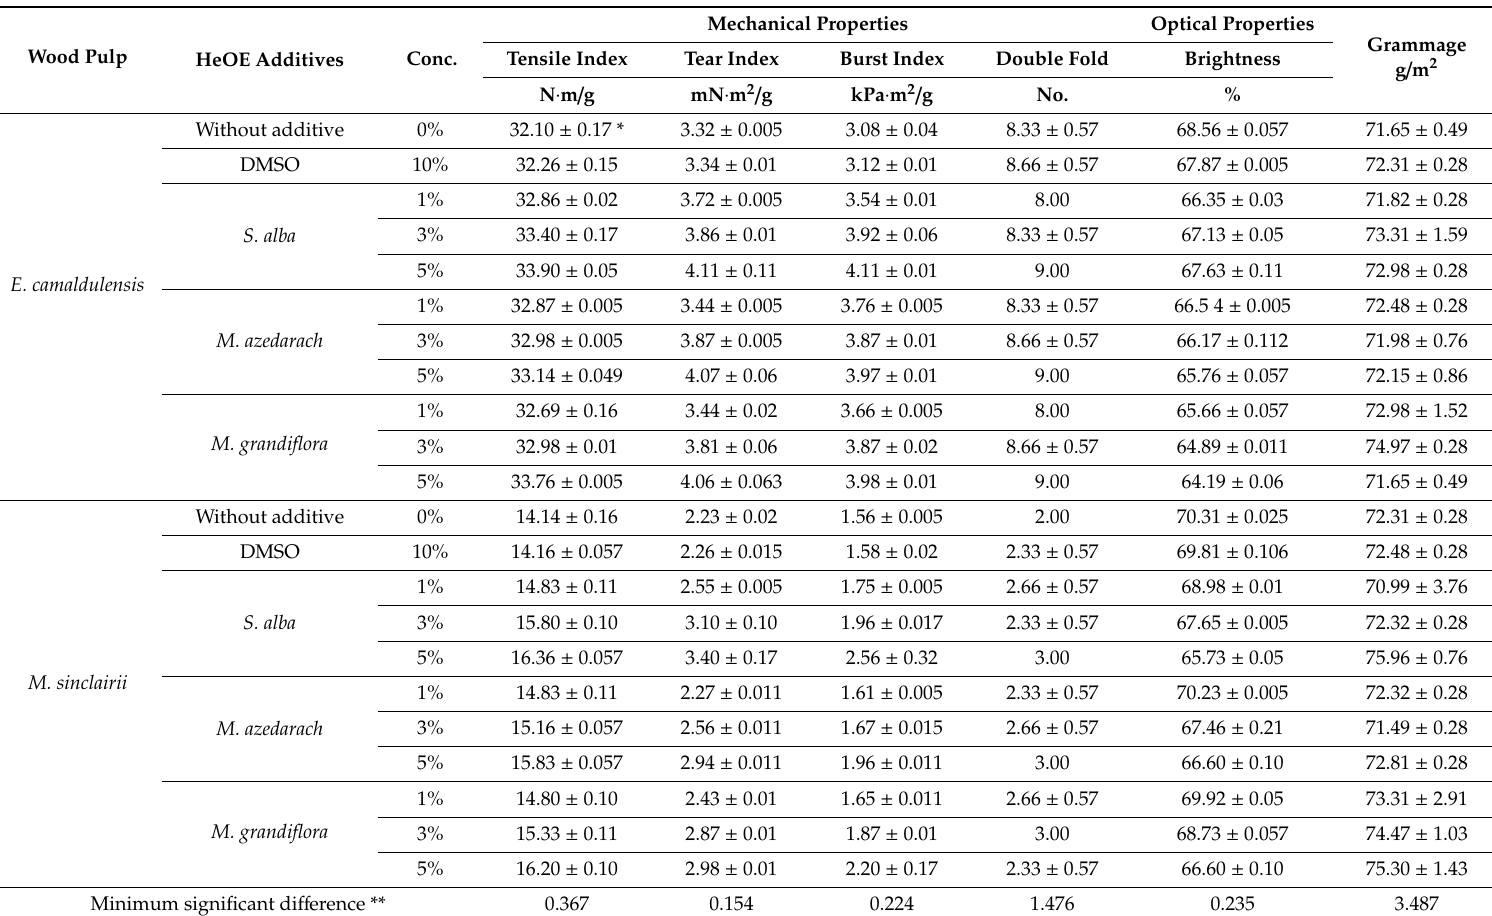
Table 5. E ff ects of di ff erent HeOEs with their concentrations on mechanical and optical properties of the produced paper sheets from pulps of E. camaldulensis and M. sinclairii branch